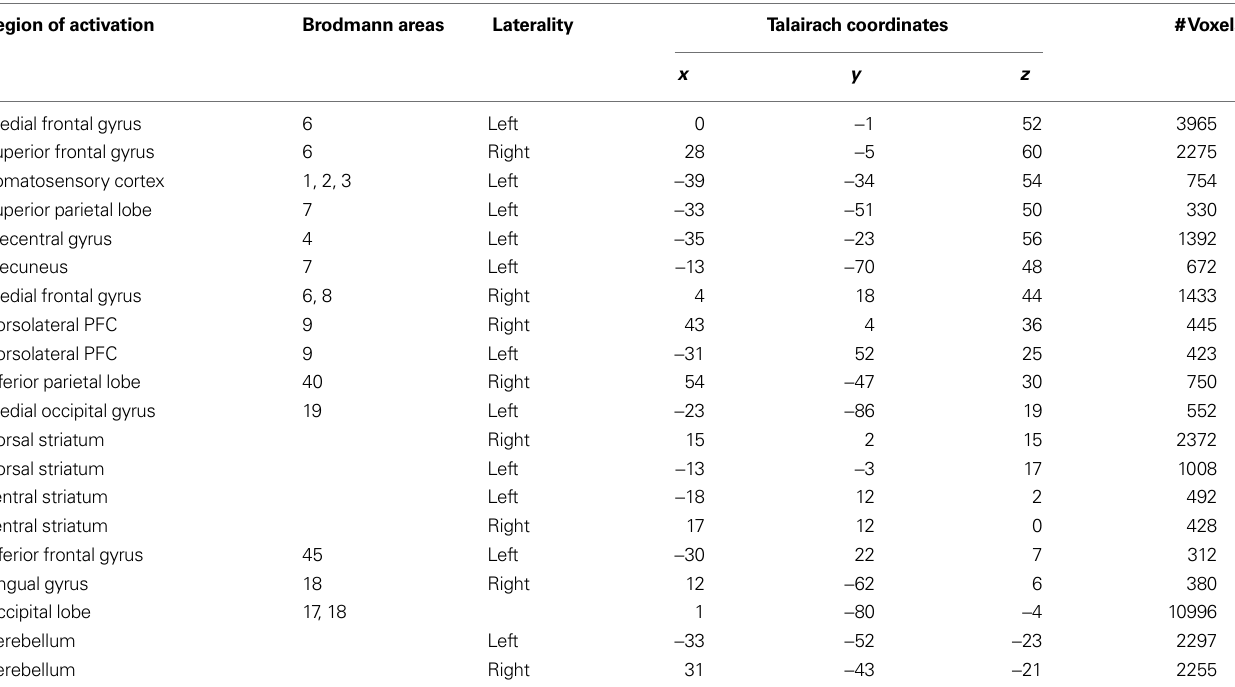
Table 1 | Contrast of aversive (CS + and AV + ) and Safe (CS − ) trials at FDR < 0.01 and contiguity threshold of 10